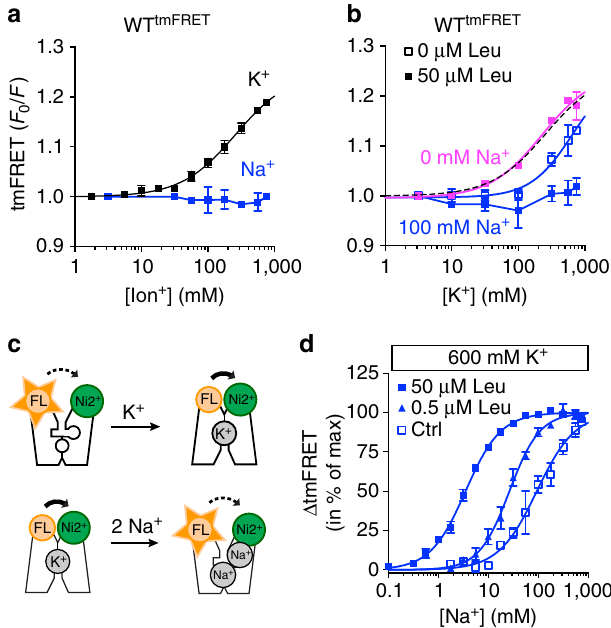
Figure 4 | K þ induced conformation competes with the coupled binding conformation of Na þ and leucine. ( a ) tmFRET between EL4 and TM10 as a function of K þ (black) and Na þ (blue) concentrations. K þ produces a tmFRET-specific increase that fitted by the Hill equation indicates a single binding site ( n Hill ¼ 1.06 ± 0.15) having an EC 50 ¼ 260 [137;495] mM. Na þ showed no conformational effect. ( b ) The conformational effect by K þ is attenuated by Na þ and further blocked with leucine. Addition of Na þ (100mM) right-shifted the K þ generated tmFRET response (blue, open squares) relative to K þ alone from a (dotted line). Further addition of leucine (50 m M) completely inhibited the K þ response (blue closed squares). The effect by leucine was Na þ -dependent since substitution with 100mM Cs þ completely removed the blockade (filled pink squares). Note that Cs þ does not support binding of leucine. ( c ) Reaction scheme for tmFRET change in response to ions, Na þ binding may be assayed by competitively inhibiting K þ -induced conformational change. Dotted arrow indicates low tmFRET, that is, high fluorescence; solid arrow indicates high tmFRET. ( d ) Normalized change in tmFRET between EL4 and TM10 ( F 0 / F ) as a function of [Na þ ]. LeuT A313H-A317H-K398C FL (WT tmFRET ) is stabilized in the K þ -bound conformation with 600mMK þ and ‘back titrated’ with Na þ , in the presence of 0, 0.5 or 50 m M Leu, which results in a EC 50 (in mM) for Na þ of 94.0 [80.9;109], 26.6 [23.9;29.6] and 3.52 [3.29;3.76], respectively. Ch þ was substituted for Na þ or K þ to maintain ionic strength. All the data are performed in 750 m M Ni 2 þ . Data are means ± s.e.m. EC 50 is given as mean with 95% confidence interval, n ¼